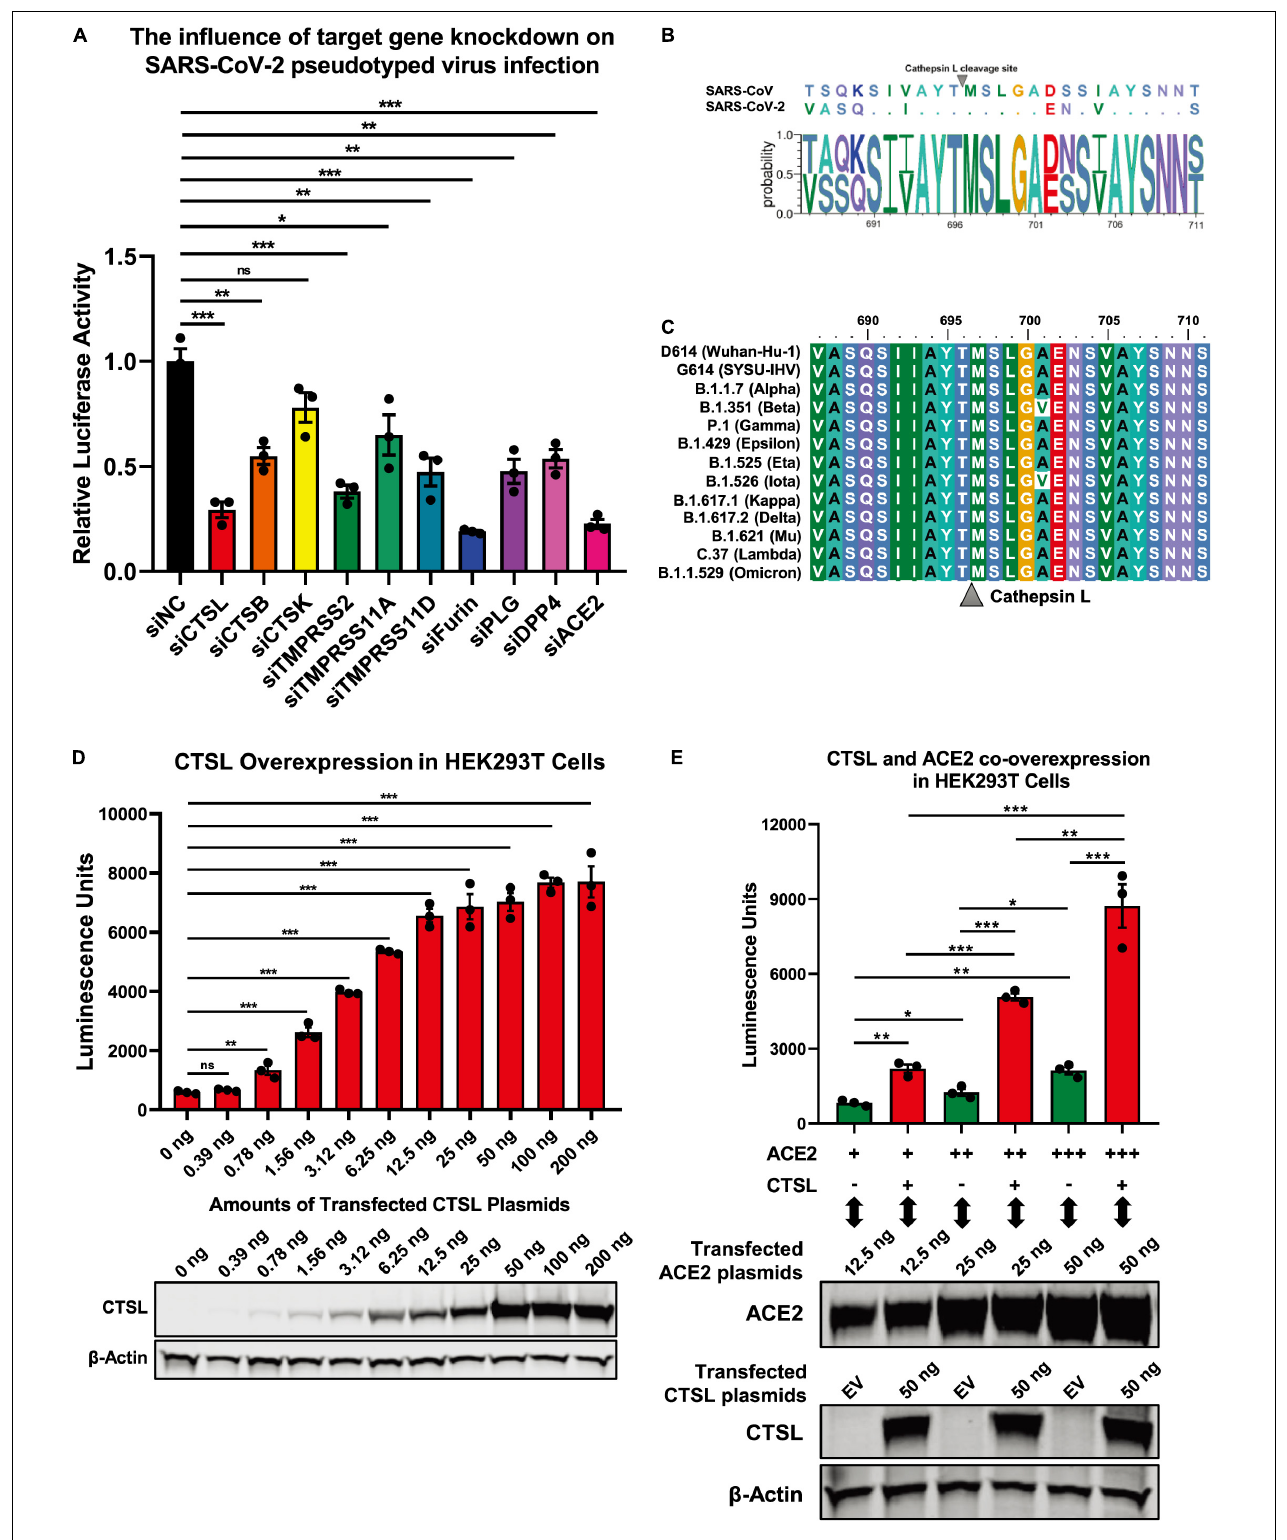
FIGURE 1 | SARS-CoV-2 infection depended on the activity of CTSL. (A) CTSL, CTSB, CTSK, TMPRSS2, TMPRSS11A, TMPRSS11D, Furin, PLG, DPP4, and ACE2 in HEK293T cells were knocked down by siRNAs. These cells were infected with pseudotyped SARS-CoV-2 viruses 24 h post transfection. The intracellular